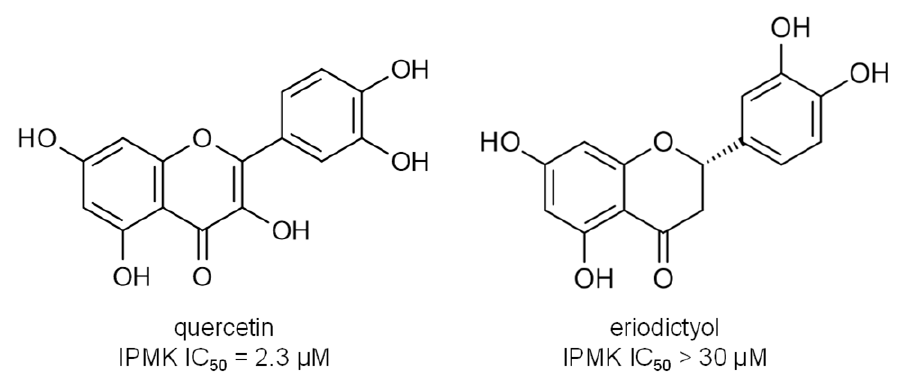
Figure 6. Comparison of structures of quercetin and eriodictyol and their inhibitory activity against human inositol polyphosphate multikinase (IPMK). IC 50 values from [108].